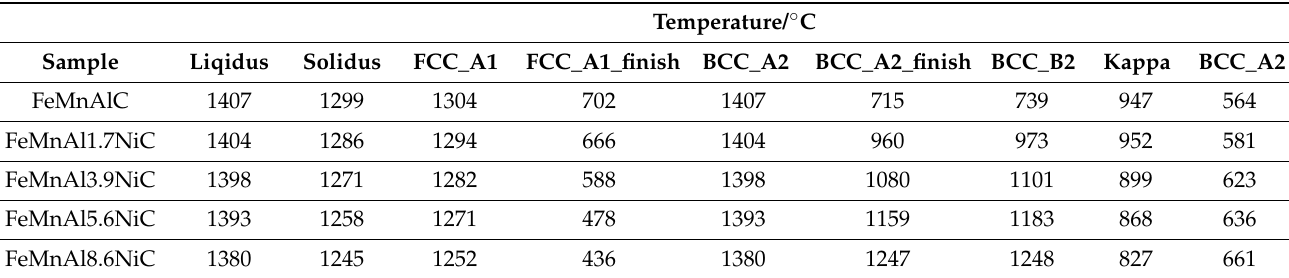
Table 2. Characteristic temperatures of the equilibrium phases. Table 2 . Characteristic temperatures of the equilibrium phases.